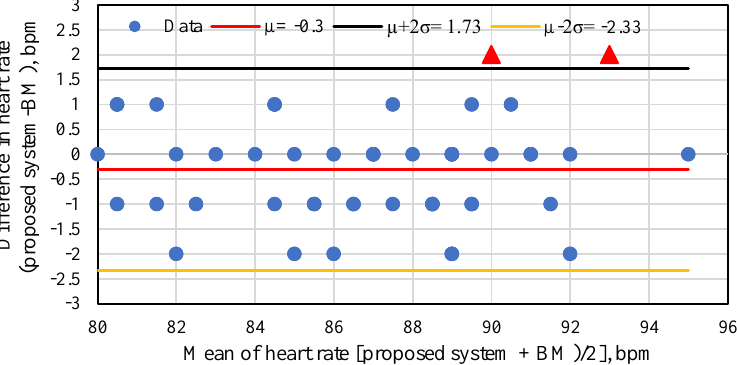
Figure 10. Bland–Altman plot for WHR measurements in beats per minute (bpm).